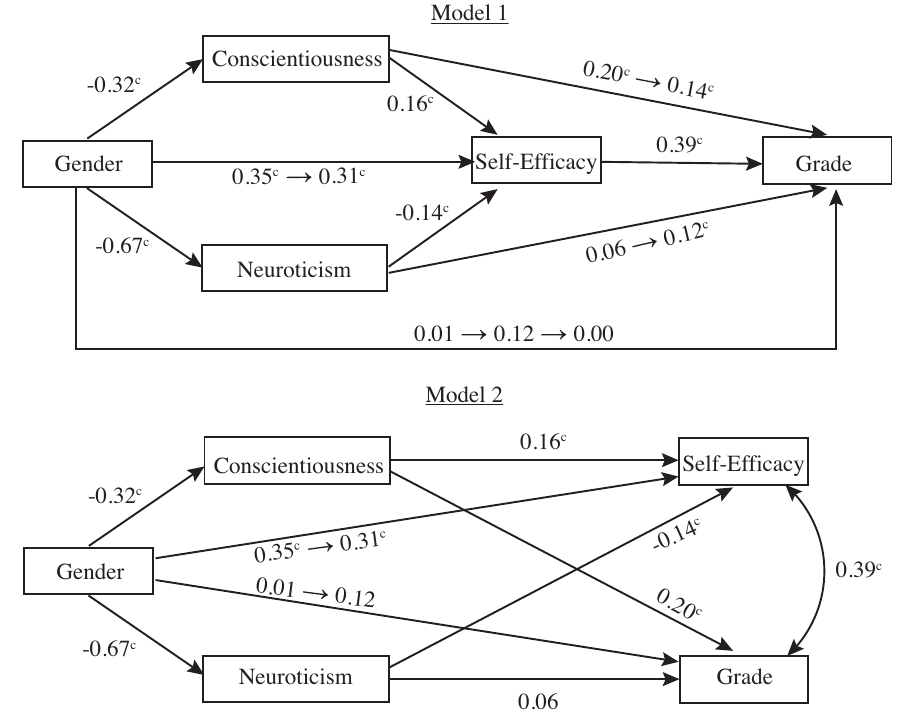
FIG. 3. Path models showing the relation of gender, personality, and self-efficacy for students in Physics 1. Gender was coded with women as zero, men as one. The number on each path is the value of the regression coefficient. The notation # 1 → # 2 shows the change in the coefficient before ( # 1 ) and after ( # 2 ) the addition of the mediating variables. Compare the figure with Fig. 2 for the symbolic variable related to each number. Note: “ a ” denotes p < 0 . 05 , “ b ” p < 0 . 01 , and “ c ” p < 0 . 001 . A Bonferroni correction was applied to the significance